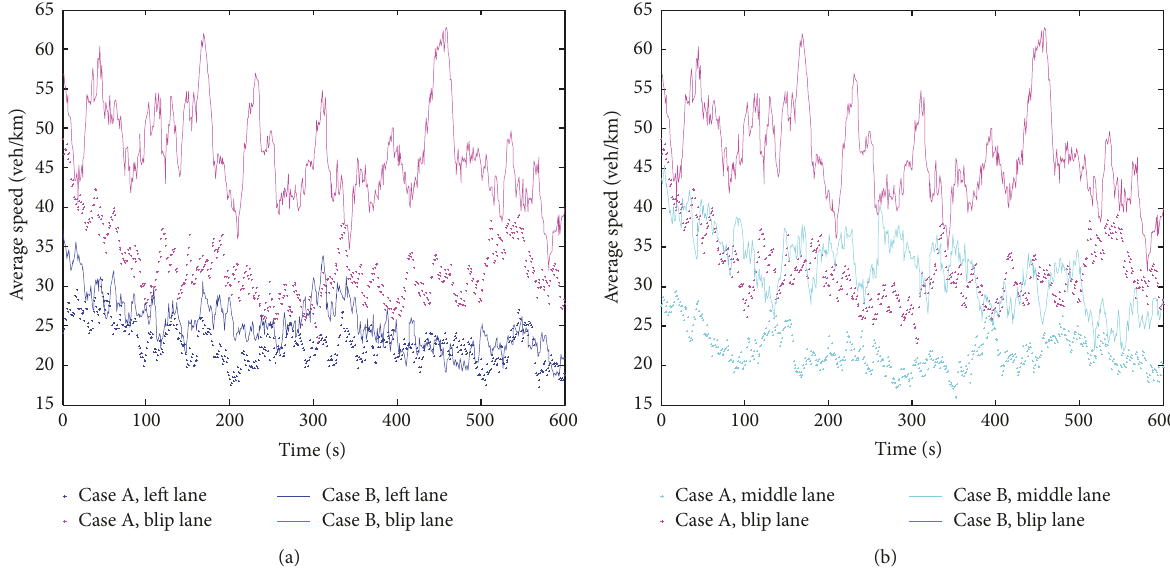
Figure 3: Average speed distributions of Case A and Case B. (a) Average speed distributions of the left and right (BLIP) lane in Case A and Case B. (b) Average speed distributions of the middle and right (BLIP) lane in Case A and Case